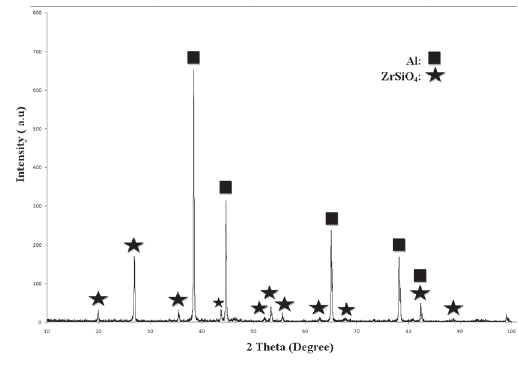
Figure 1: XRD pattern of aluminum- zircon composite sintered at 450°C.